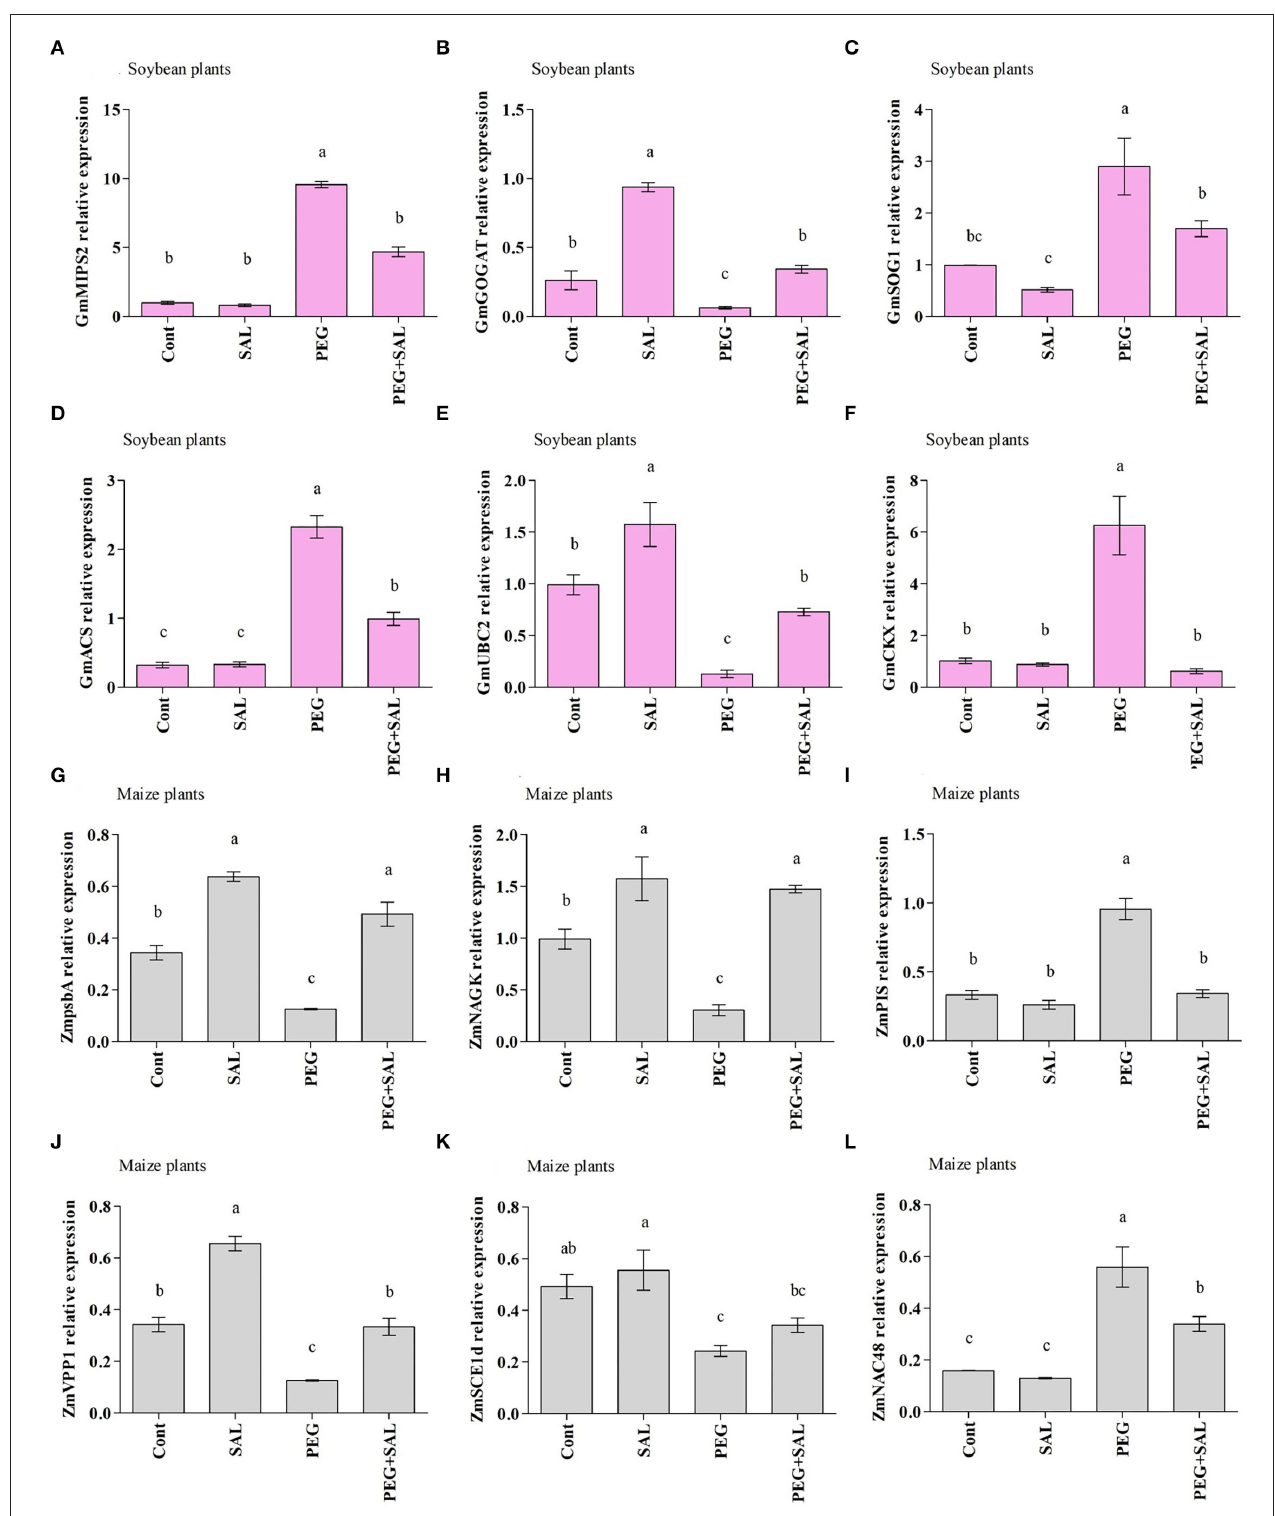
FIGURE 7 | Real-time expression analysis of GmMIPS2 (A) , GmGOGAT (B) , GmSOG1 (C) , GmACS (D) , GmUBC2 (E) , GmCKX (F) , ZmpsbA (G) , ZmNAGK (H) , ZmPIS (I) , ZmVPP1 (J) , ZmSCE1d (K) , and ZmNAC48 (L) in leaves of soybean and maize plants grown under normal and stress conditions and treated with salvianolic acid for 8 days (8DAT). Treatments: Cont (control), SAL (0.1 µ M salvianolic acid), SAL (1 µ M salvianolic acid), PEG (25% polyethylene glycol), SAL (0.1 µ M salvianolic acid) + PEG (25% polyethylene glycol), and SAL (1 µ M salvianolic acid) + PEG (25% polyethylene glycol). Values show the mean ± SE ( n = 6) and significant differences at p < 0.05 (Tukey’s test). Bars with different lowercase letters are significantly different from each other.